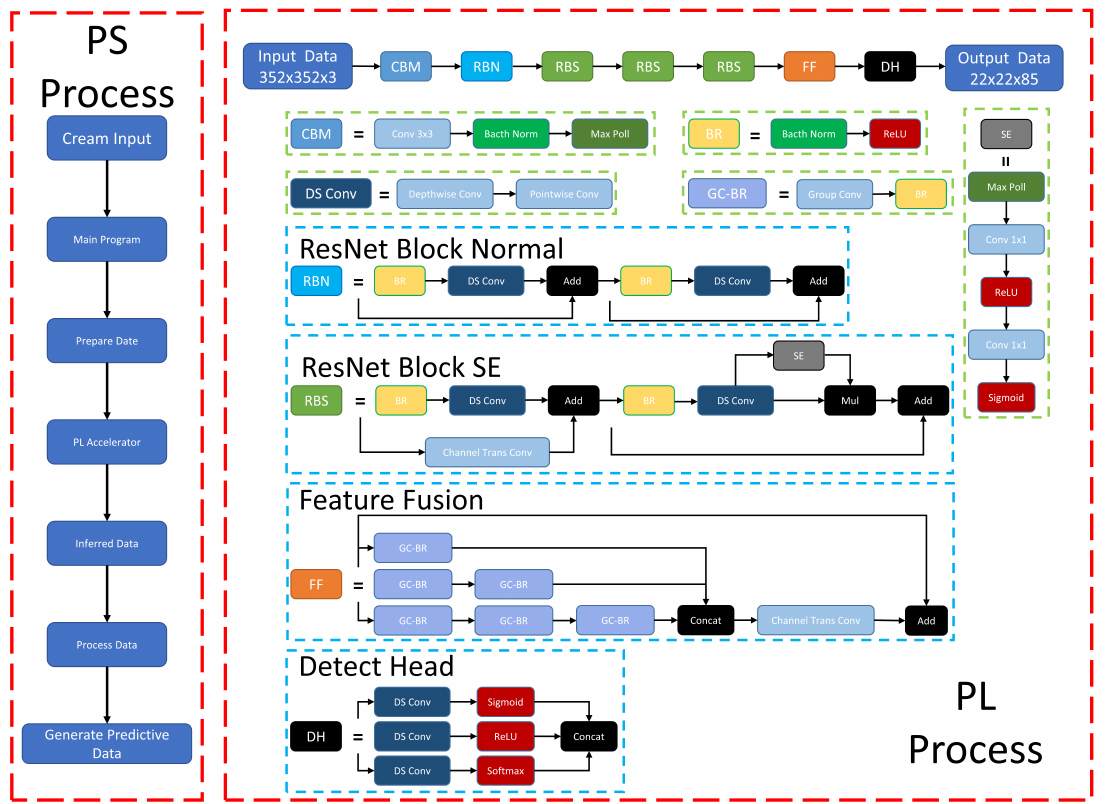
Figure 12. Overall framework of the Target Detection